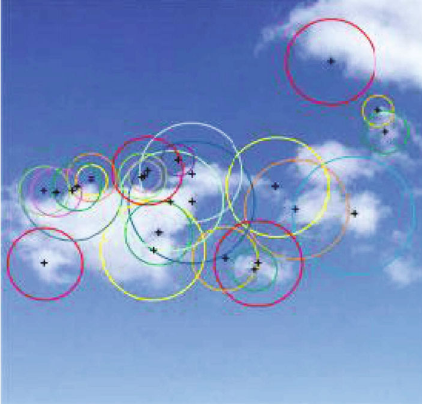
Figure 5: Feature point extraction process via SURF